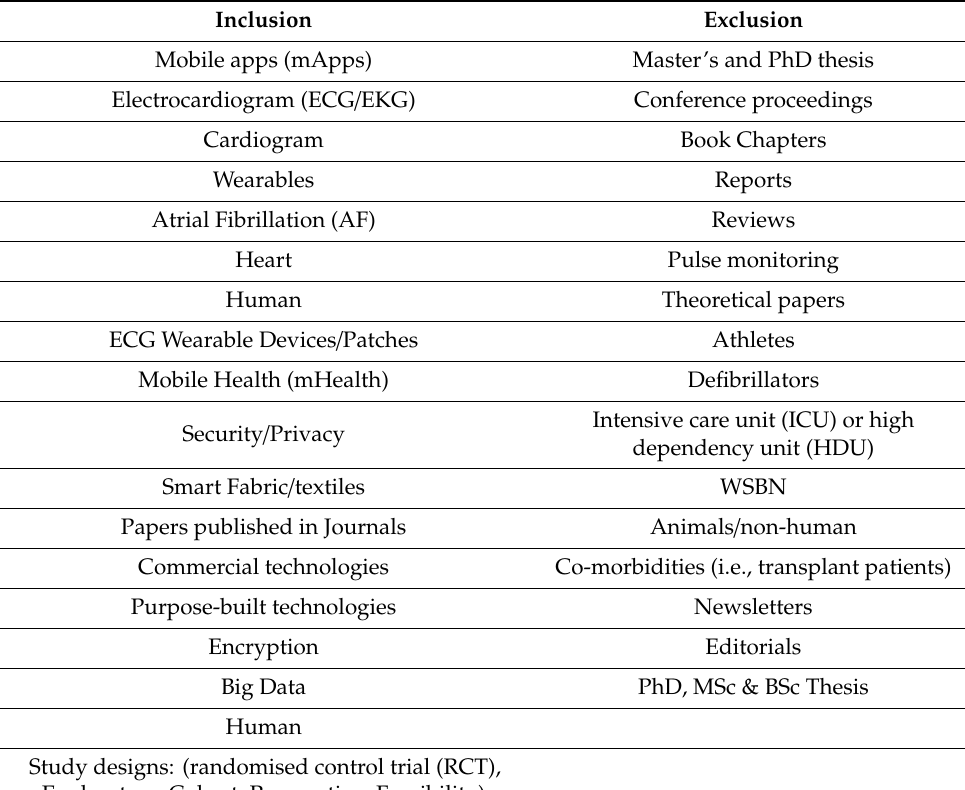
Table 1. Criteria for study